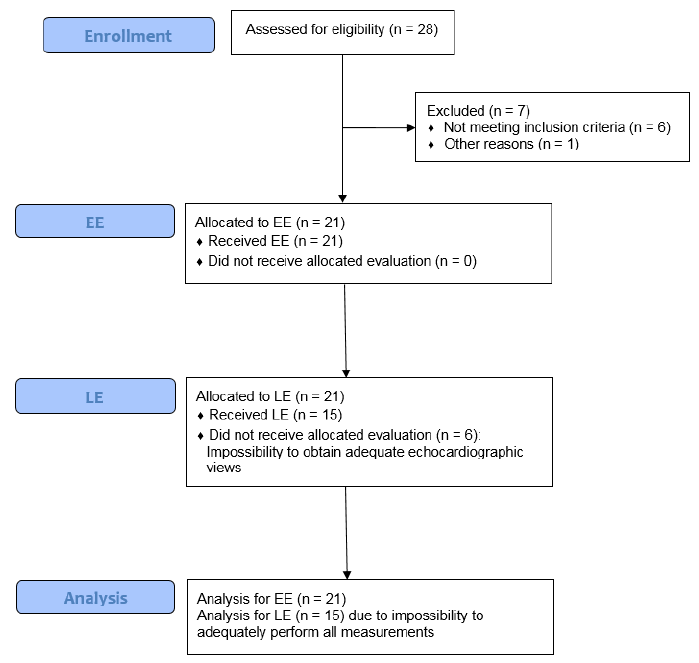
Figure 1. Consort flow diagram.